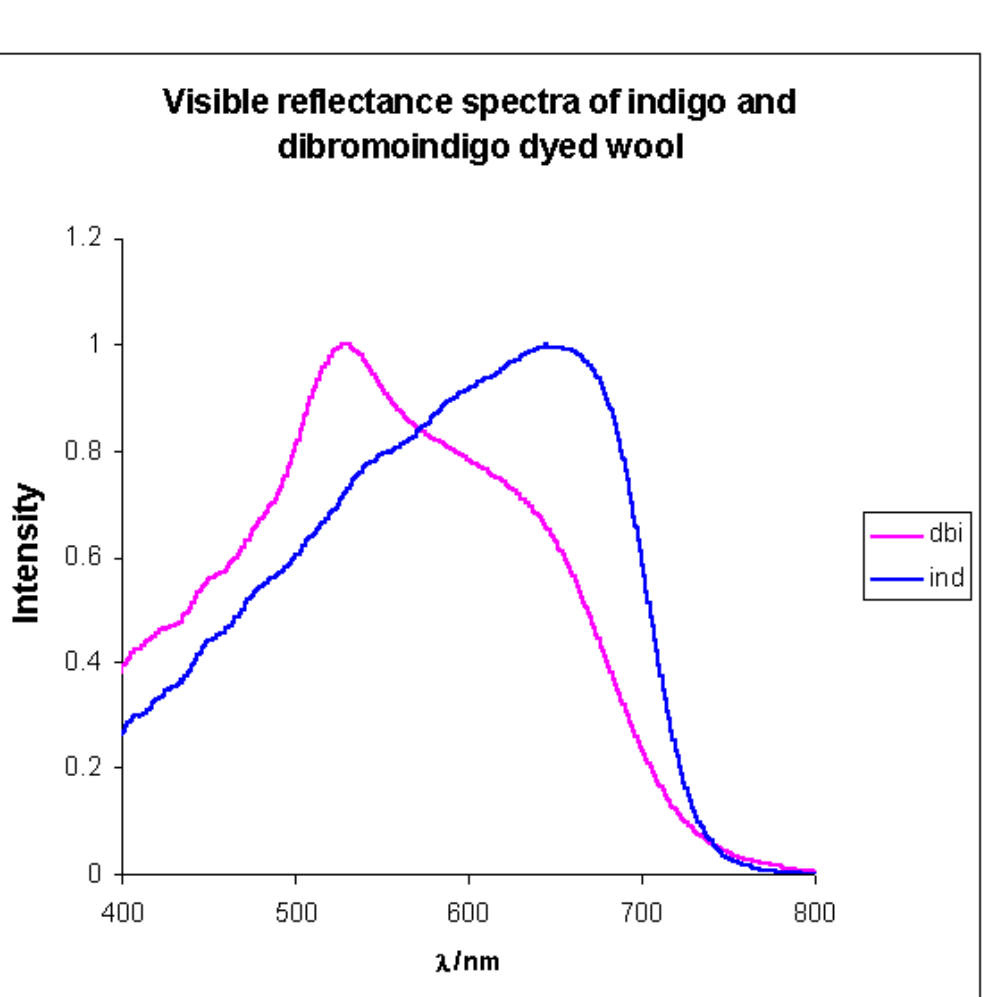
Figure 4. The visible reflectance spectra of indigo and dibromoindigo dyed wool